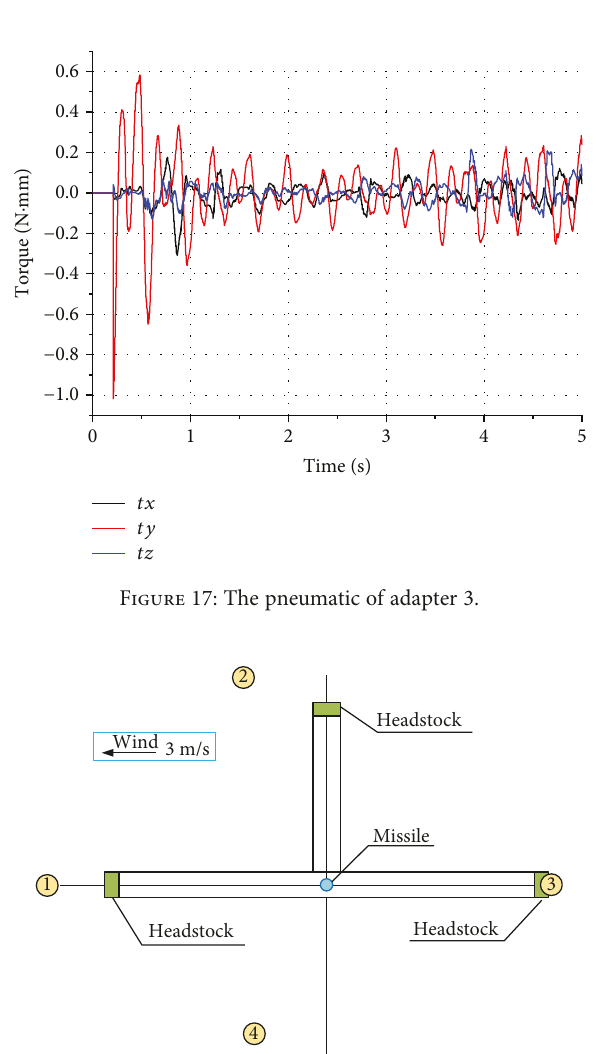
Figure 18: The adapters ’ placement with di ff erent position of